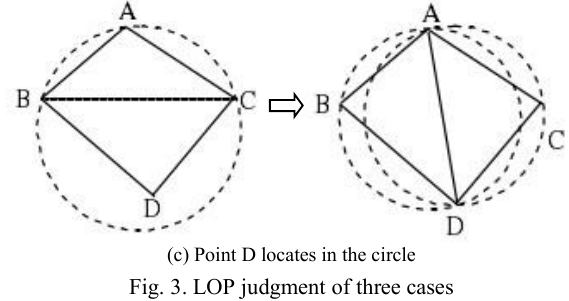
Fig. 3. LOP judgment of three